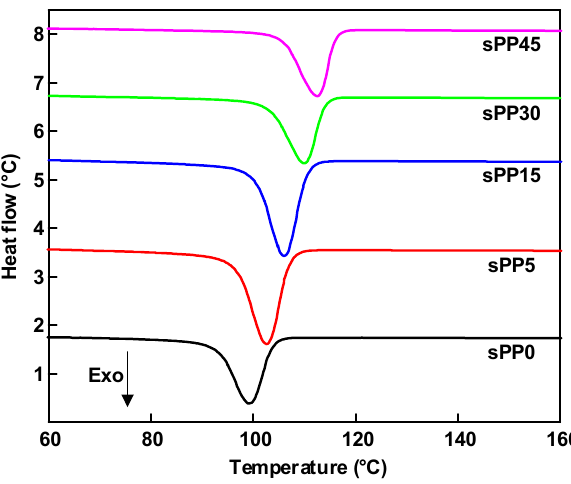
Figure 8. Crystal morphology of iPP/sPP blends. ( a ) sPP0, ( b ) sPP5, ( c ) sPP15, ( d ) sPP30, ( e ) sPP45.